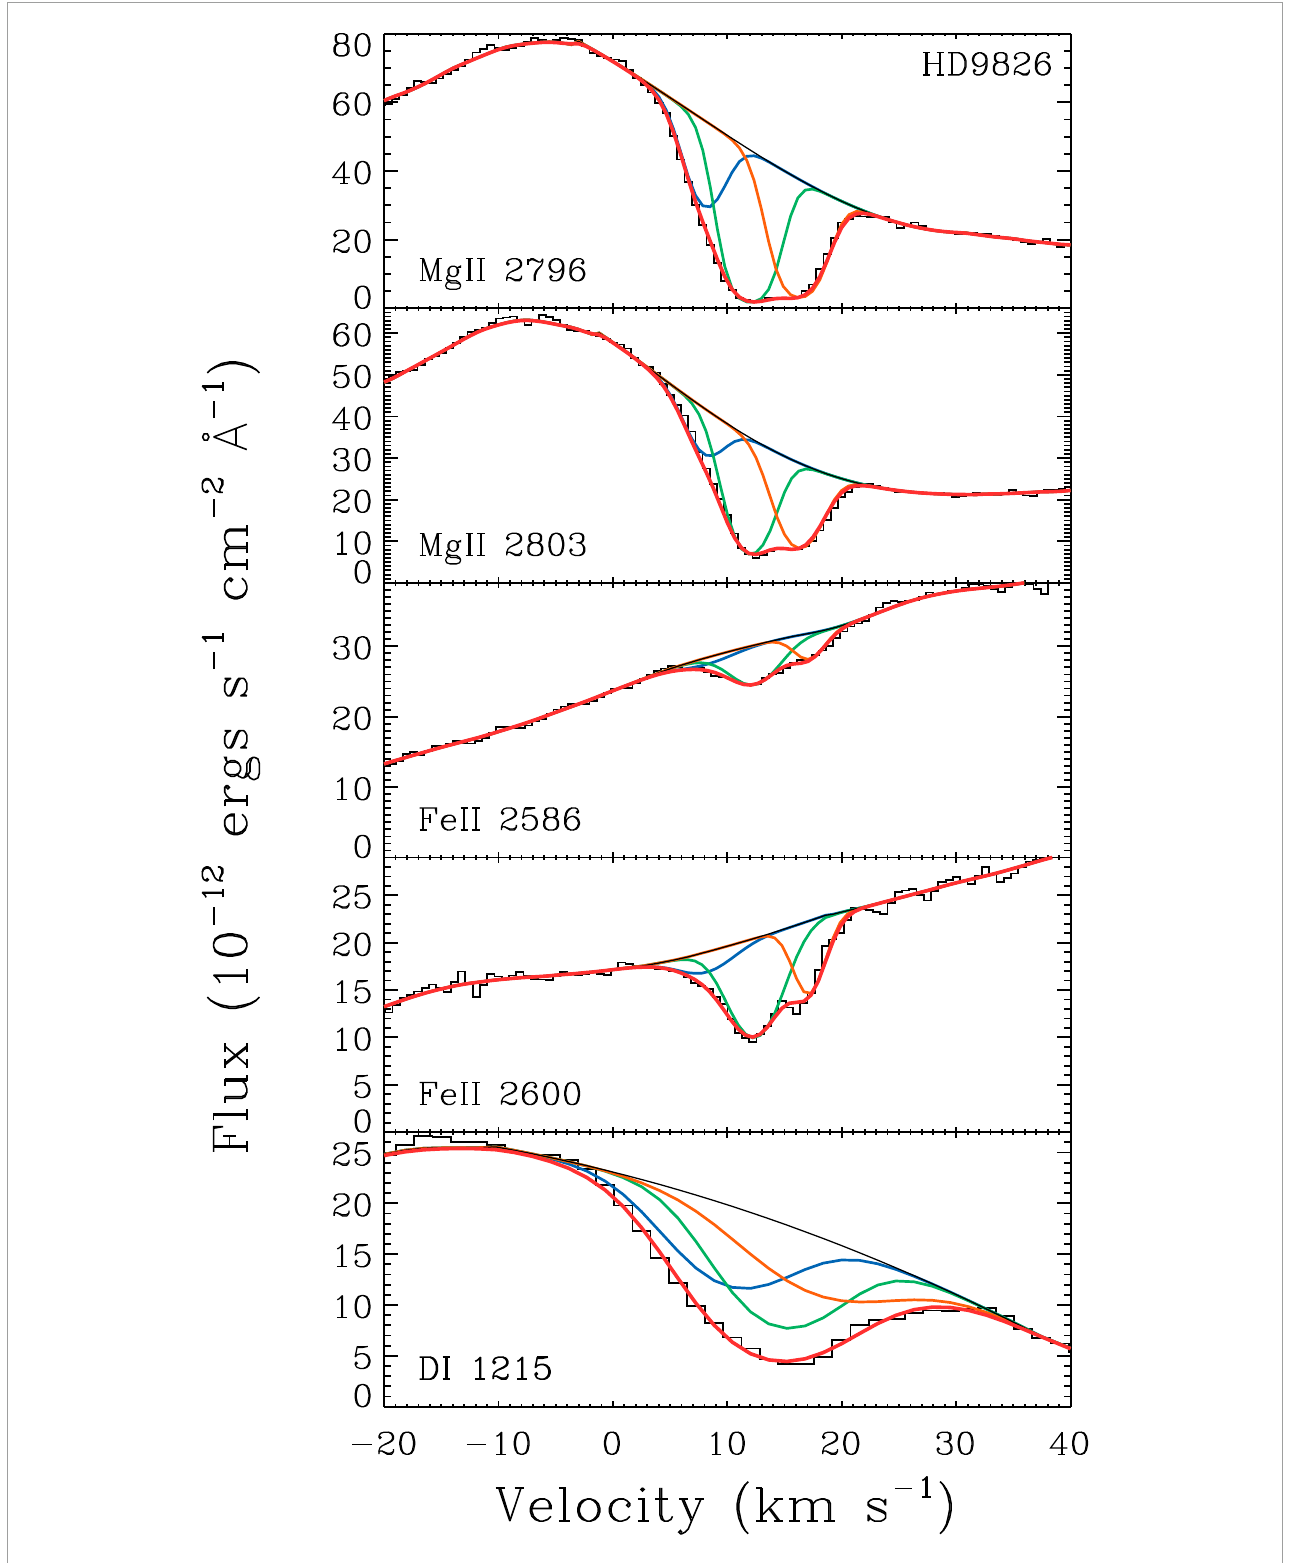
FIGURE 1 An example of a three velocity component fit to the star HD 9826 (F9 V). The separation of the three components is clearer in the high mass Fe II and Mg II spectral lines where thermal broadening is unimportant, but the three components are hard to distinguish in the D I Lyman- α line for which thermal broadening dominates. Figure from Edelman et al.